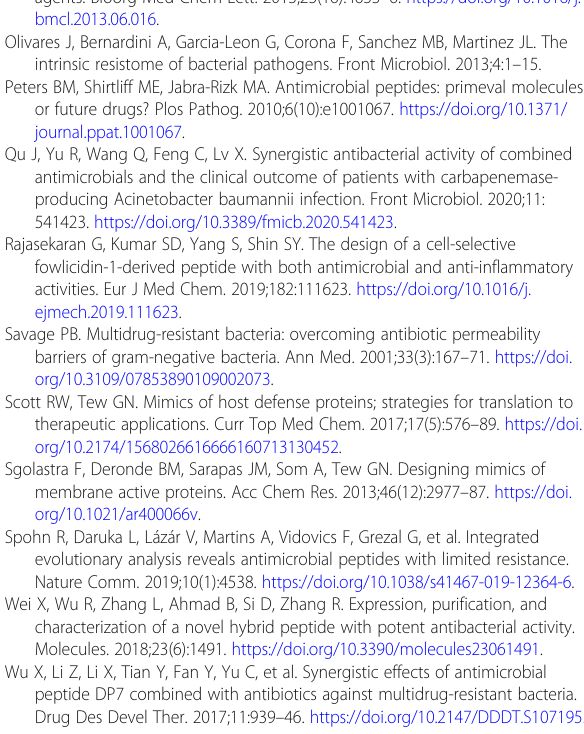
Abbreviations AMP: Antimicrobial peptide; SAMP: Short histidine-derived antimicrobial pep- tidomimetic; MDRPA: Multidrug-resistant Pseudomonas aeruginosa ; MDRE C: Multidrug-resistant Escherichia coli ; MIC: Minimum inhibitory